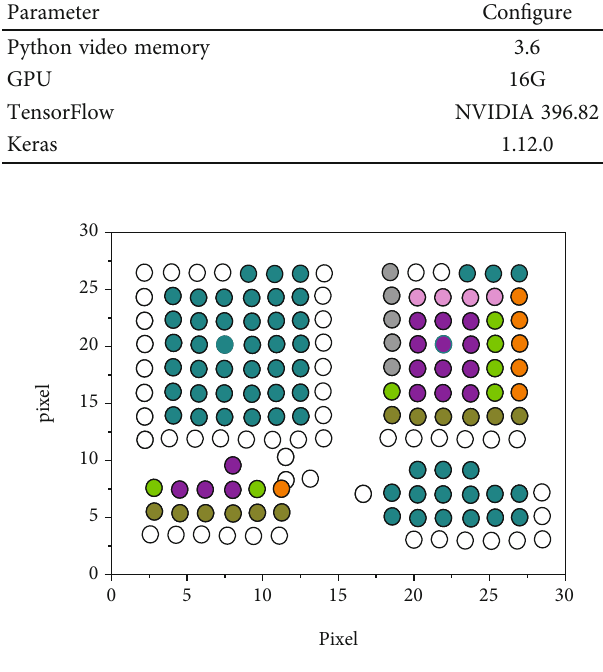
Figure 4: Improved boundary search